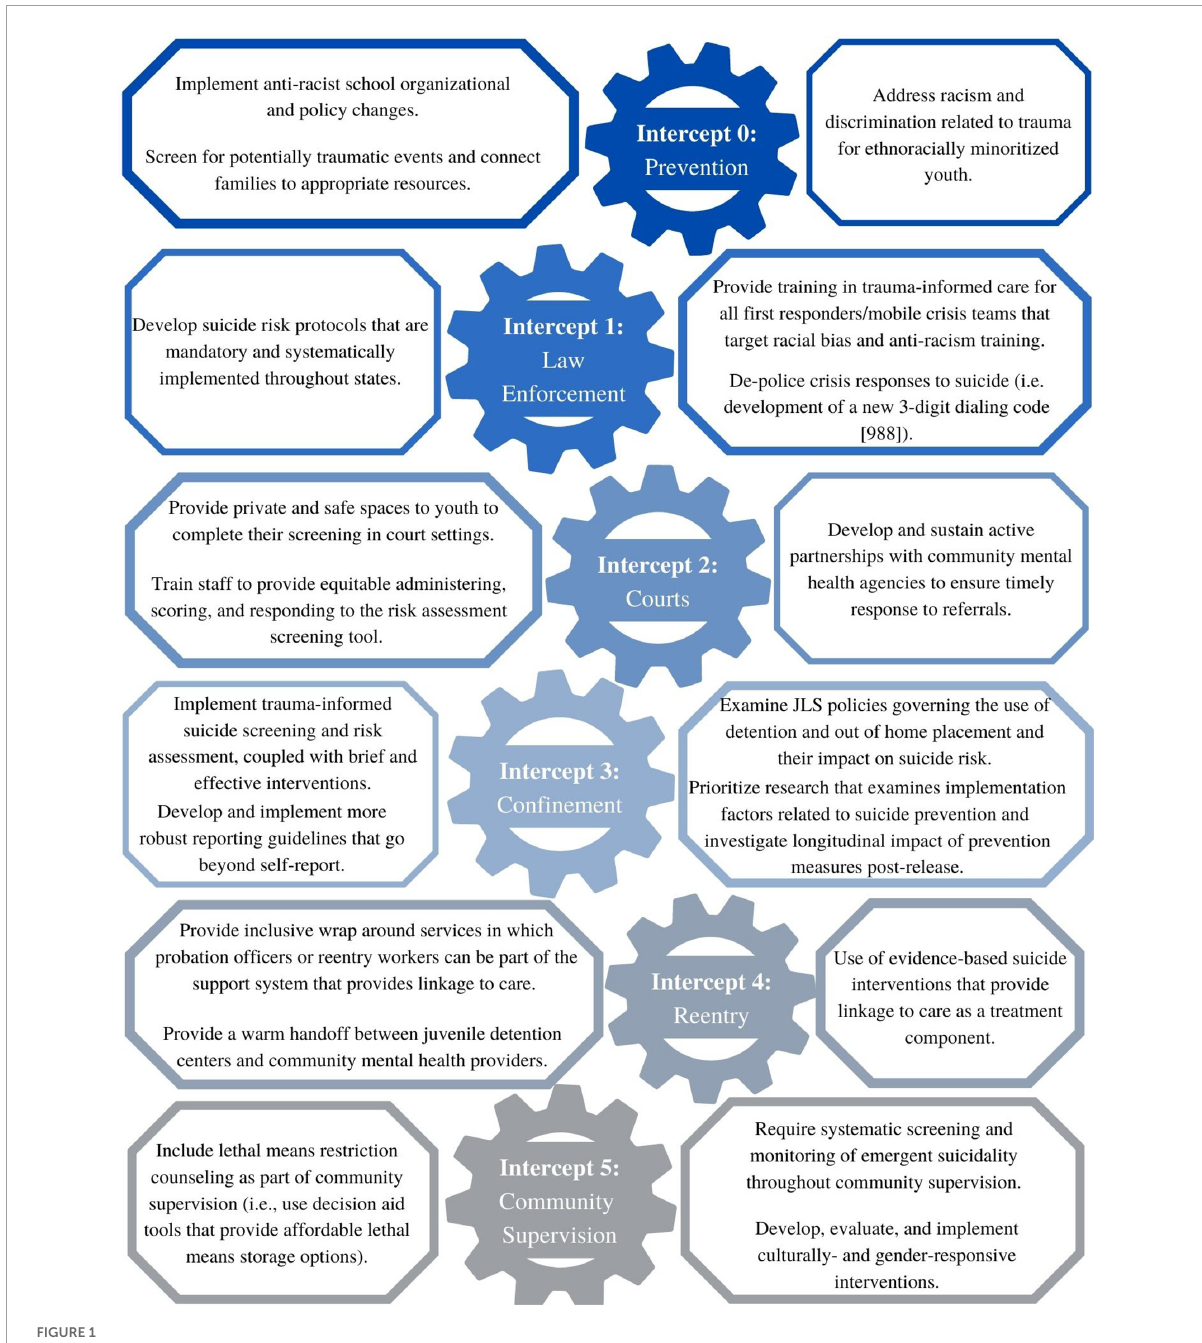
FIGURE1 Equitable suicide prevention strategies across the Sequential Intercept Model.